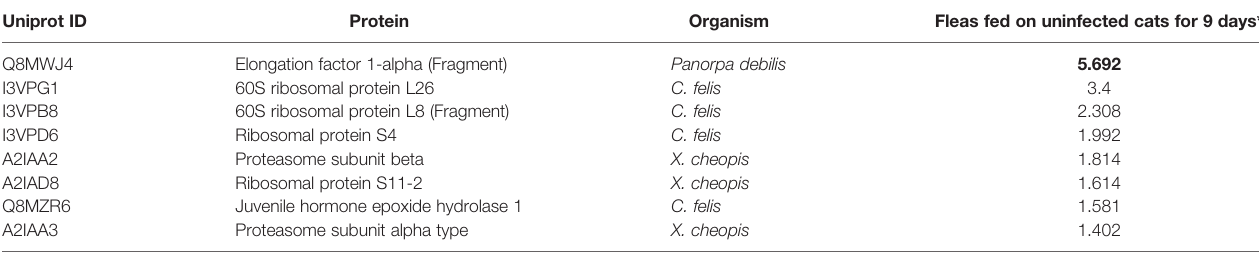
TABLE 4 | Uniprot identi fi cation number, associated protein, and reference organism of FDAP (Flea Differentially Abundant Proteins) in fl eas fed on uninfected cats for 24 hours when compared to fl eas fed on uninfected cats for 9 days. Uniprot